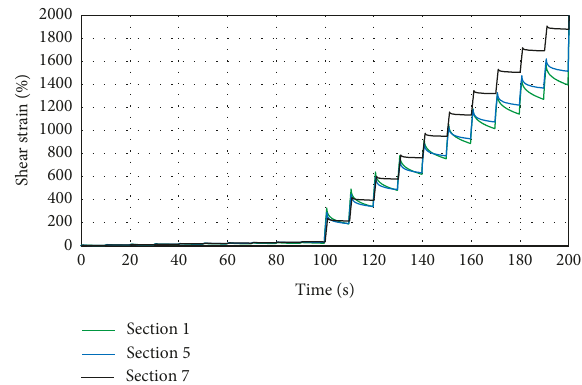
Figure 6: Progress of multiple stress creep and recovery test for chosen recovered bitumens.